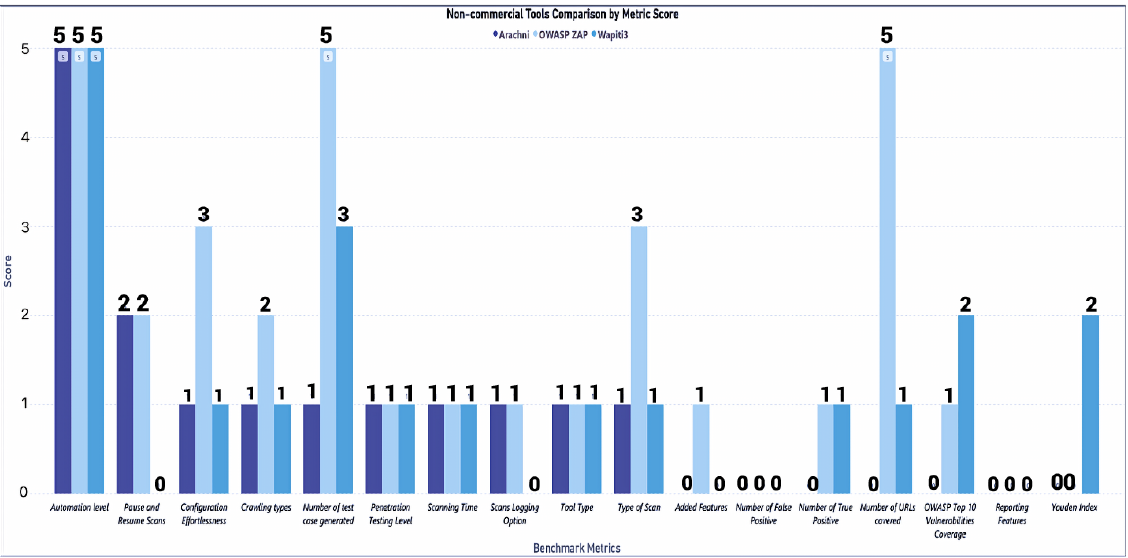
Figure 6. Comparison by metric score for non-commercial